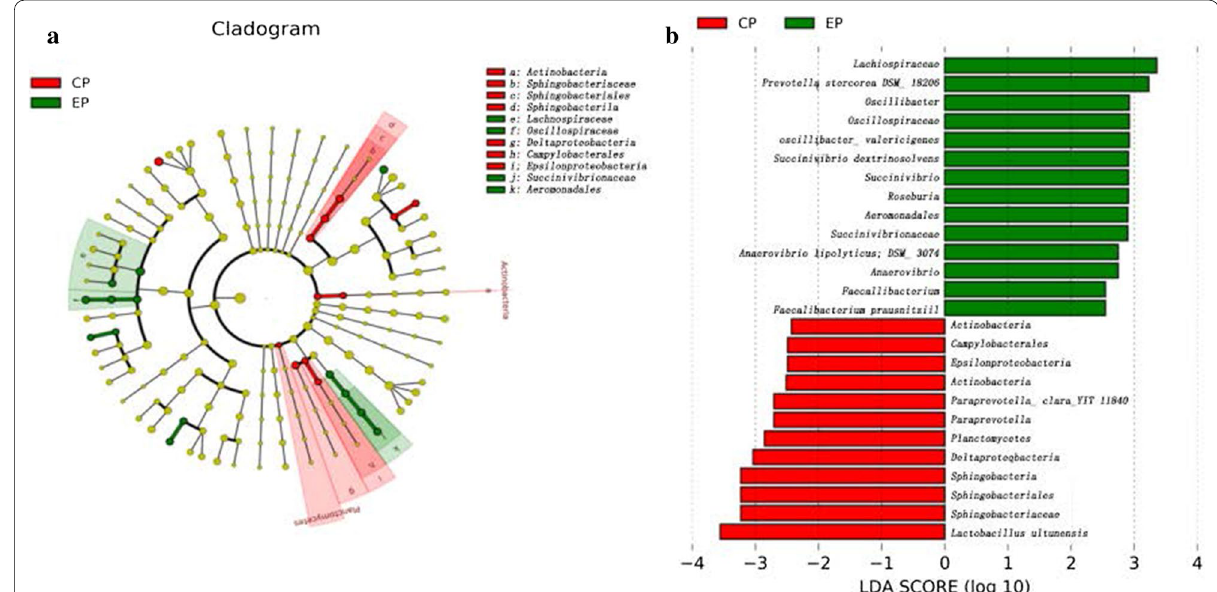
Fig. 3 Differential bacterial taxa analysis of the intestinal microbiomes in CP and EP pigs. a OTUs differentially represented at the genus level between EP and CP Chuying black pigs identified by LEfSe. Histogram showing the OTUs that were more abundant in the EP (green color) or CP (red color) Chuying black pigs, ranked by effect size. b Phylogenetic tree of the microbial communities in the CP and EP groups. The phylogenetic tree with taxonomic nodes, where the diameter of the nodes indicates relative abundance, shows the intestinal microflora in the CP and EP groups. Different groups are labeled with different colors. The red areas indicate that the bacterial species were more abundant in the CP group, and the green areas indicate that the bacterial species were more abundant in the EP